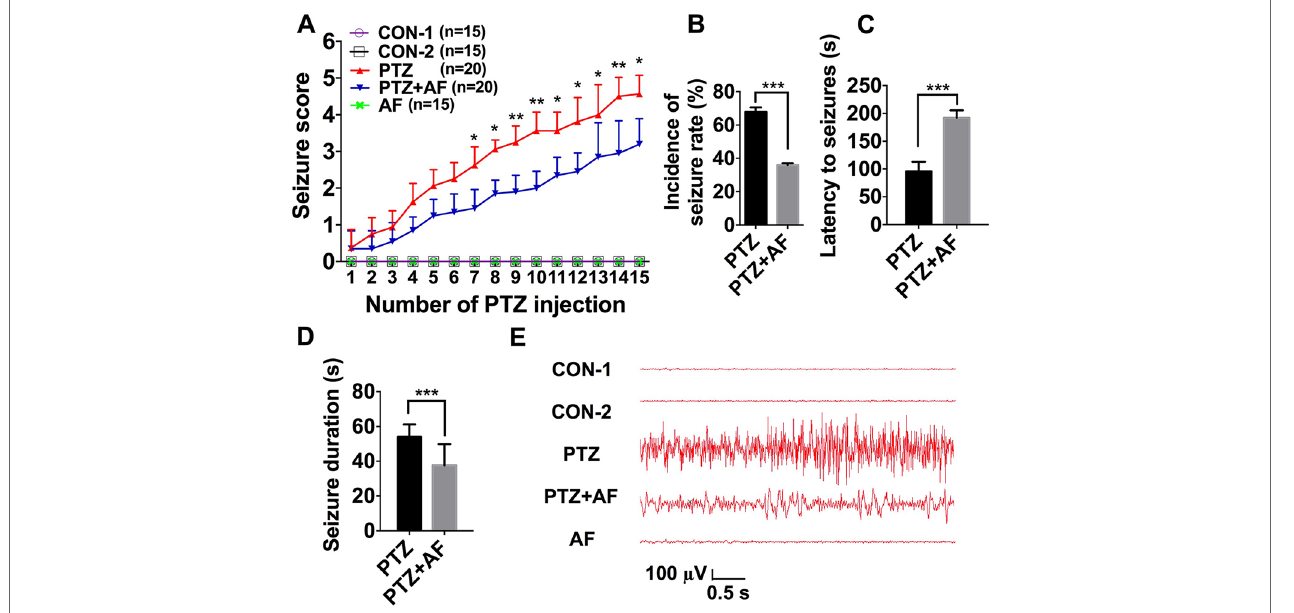
FIGURE 1 | Effects of amentoflavone on seizure susceptibility in PTZ-induced kindling in mice. (A) Statistical results showing the decrease in seizure score due to amentoflavone treatment (two-way ANOVA with repeated measures followed by Bonferroni or Dunnett’s T3 post hoc test ). (B) Statistical results showing the decrease in the incidence of full kindling due to amentoflavone treatment ( chi-square test ). (C) Statistical results showing the increase in latency to generalized seizures due to amentoflavone treatment ( Student’s t test ). (D) Statistical results showing the decrease in duration of generalized seizures due to amentoflavone